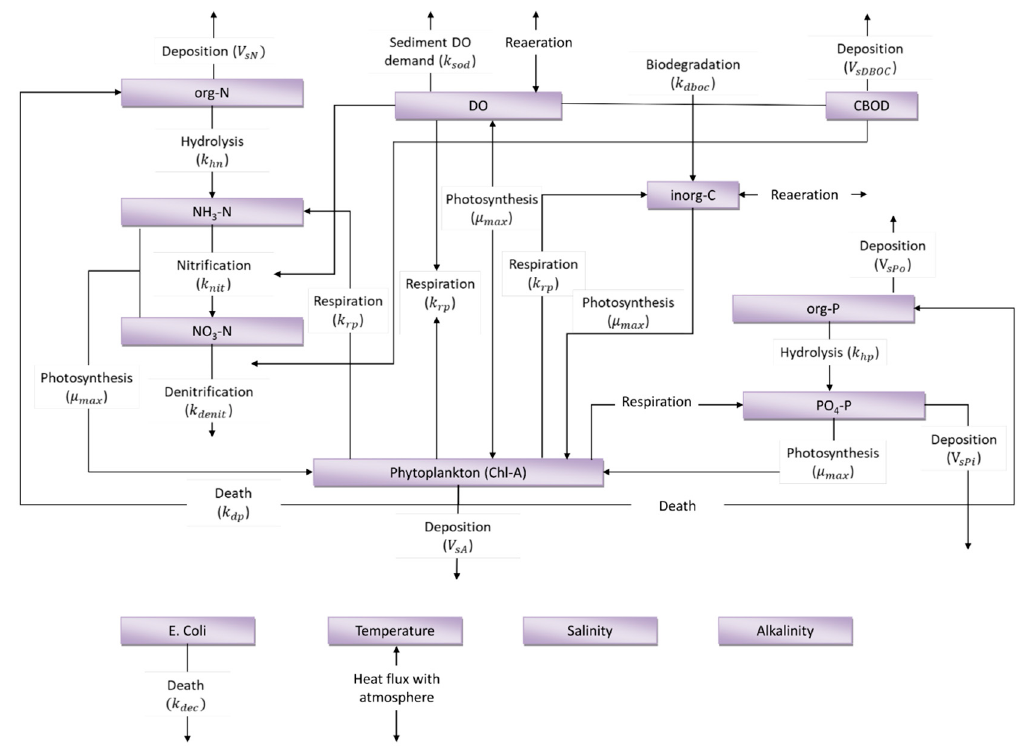
Figure 1. Model structure. Solid arrows indicate interactions between variables due to different biochemical processes.